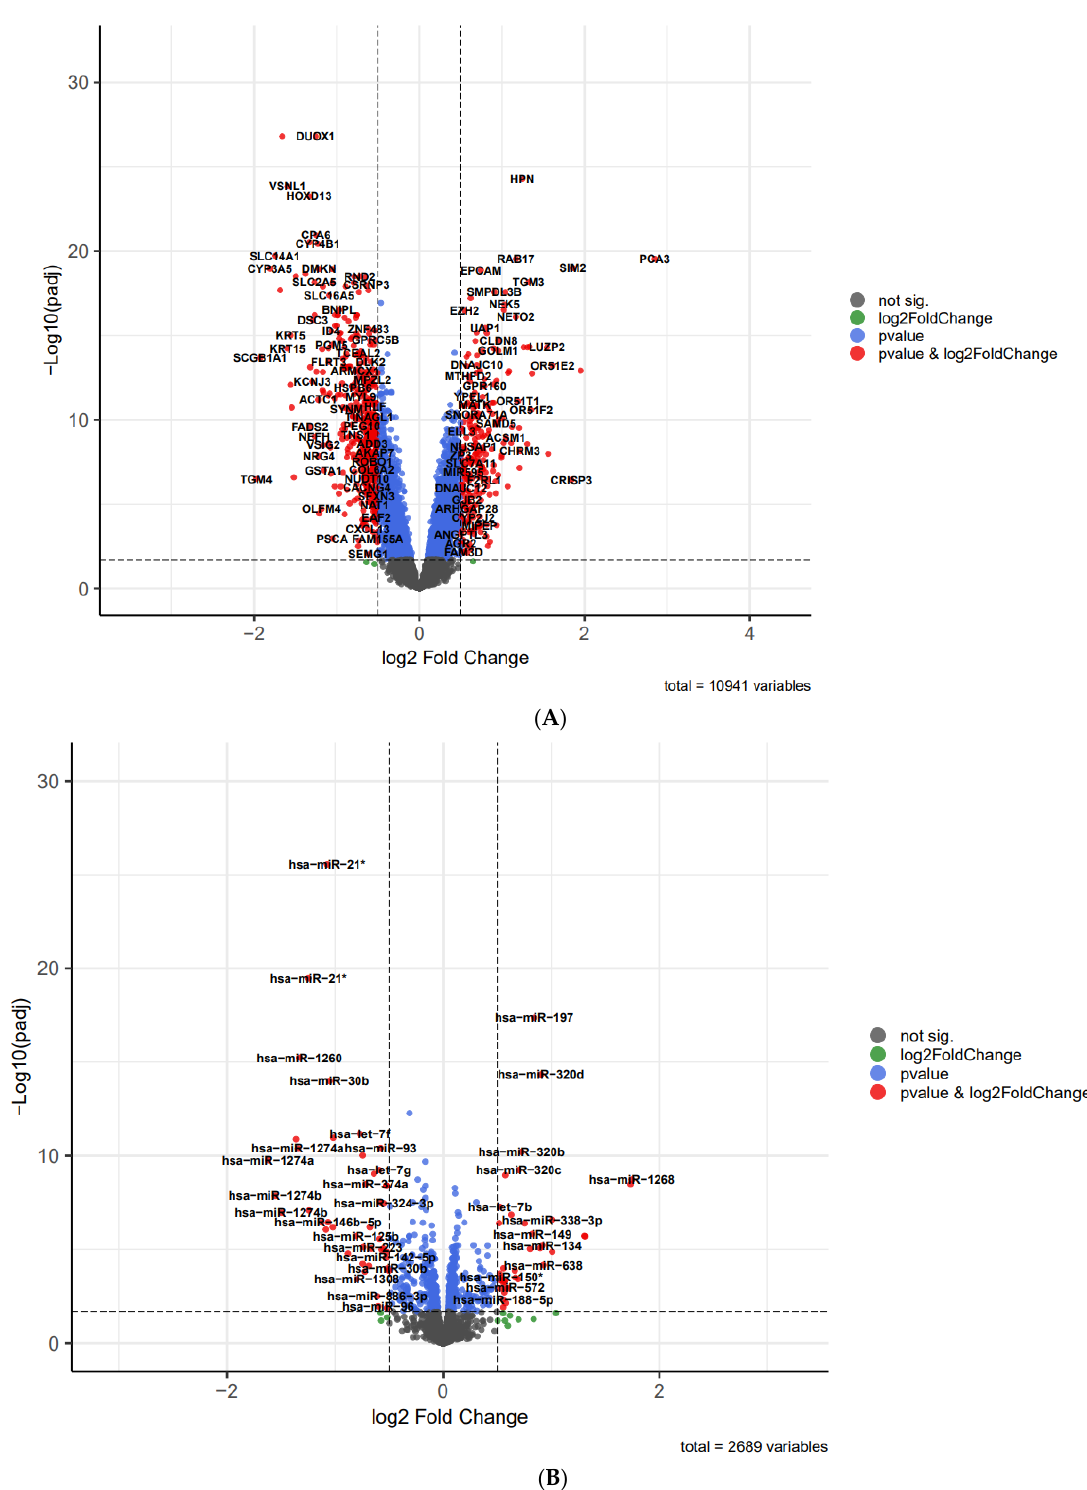
Figure 4. The volcano plot of DElncRNAs, mRNAs DEmRNAs ( A ) and DEmiRNAs ( B ); horizontal axis, log 2 (FC); vertical axis, − log 10 (adjusted p value).